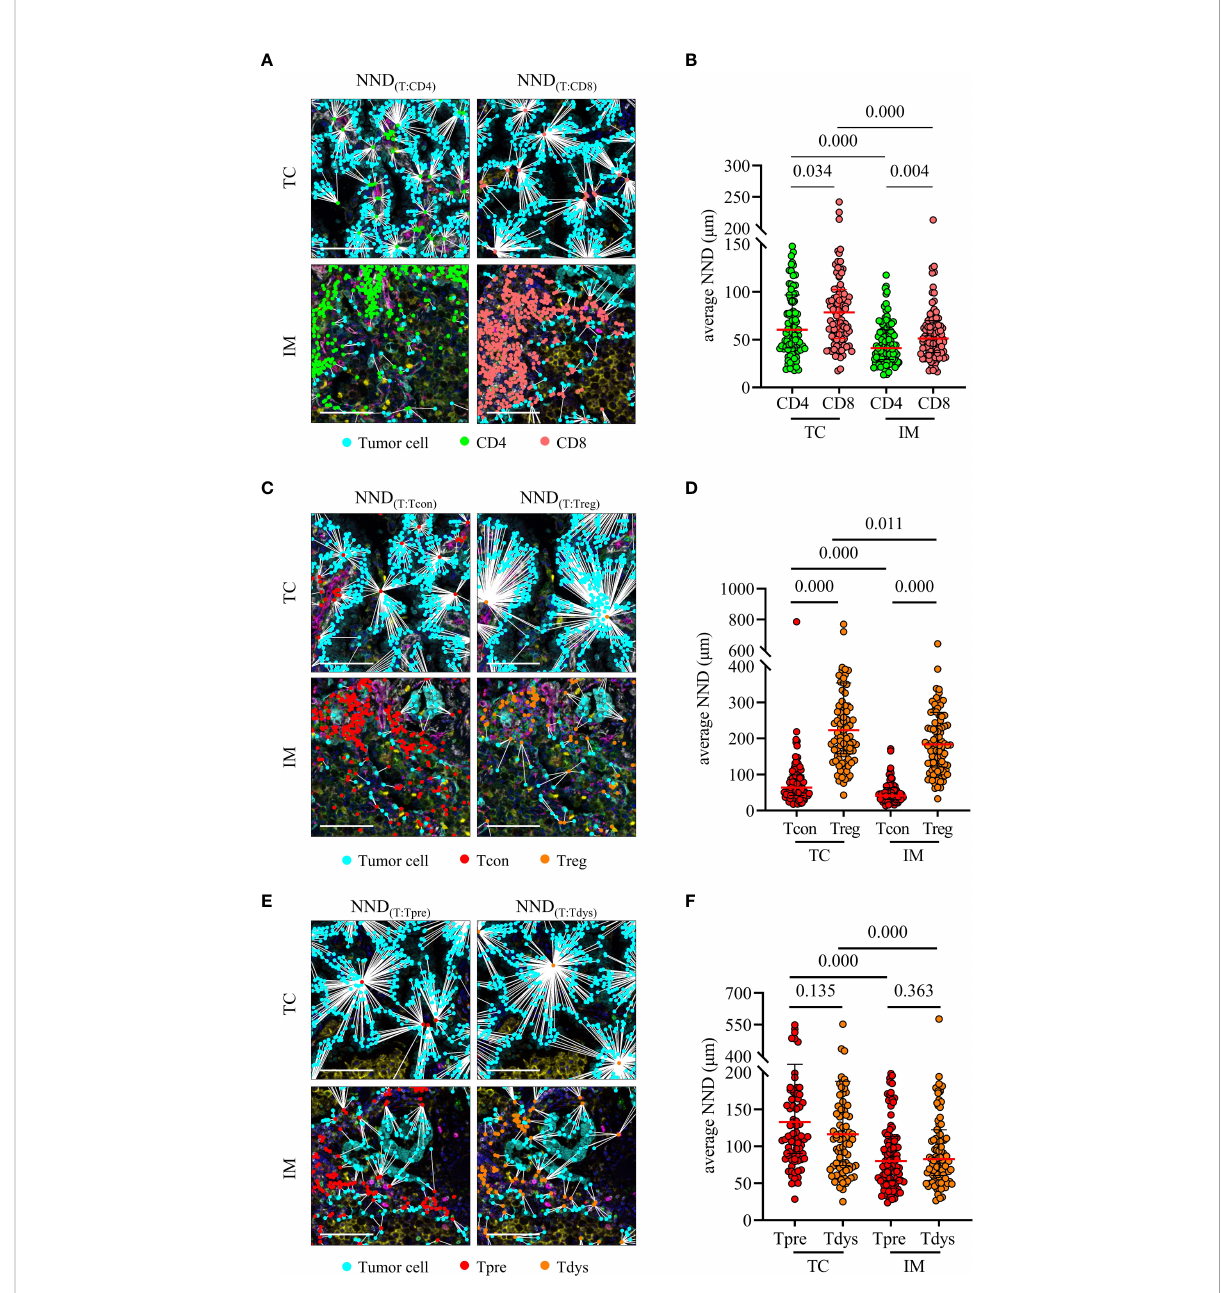
FIGURE 4 Nearest neighbor distance (NND) analysis of T cells to tumor cells. (A, B) NND was calculated from each tumor cell to their nearest CD4 or CD8 (left) and individual value plot of the average NND (right). (C, D) NND was calculated from each tumor cell to their nearest CD4 + Tcon or CD4 + Treg (left) and individual value plot of the average NND (right). (E, F) NND was calculated from each tumor cell to their nearest CD8 + Tpre or CD8 + Tdys (left) and individual value plot of the average NND (right). Scale bar, 50 m m. P values were calculated with the Mann-Whitney test, and all data are presented as the median and interquartile